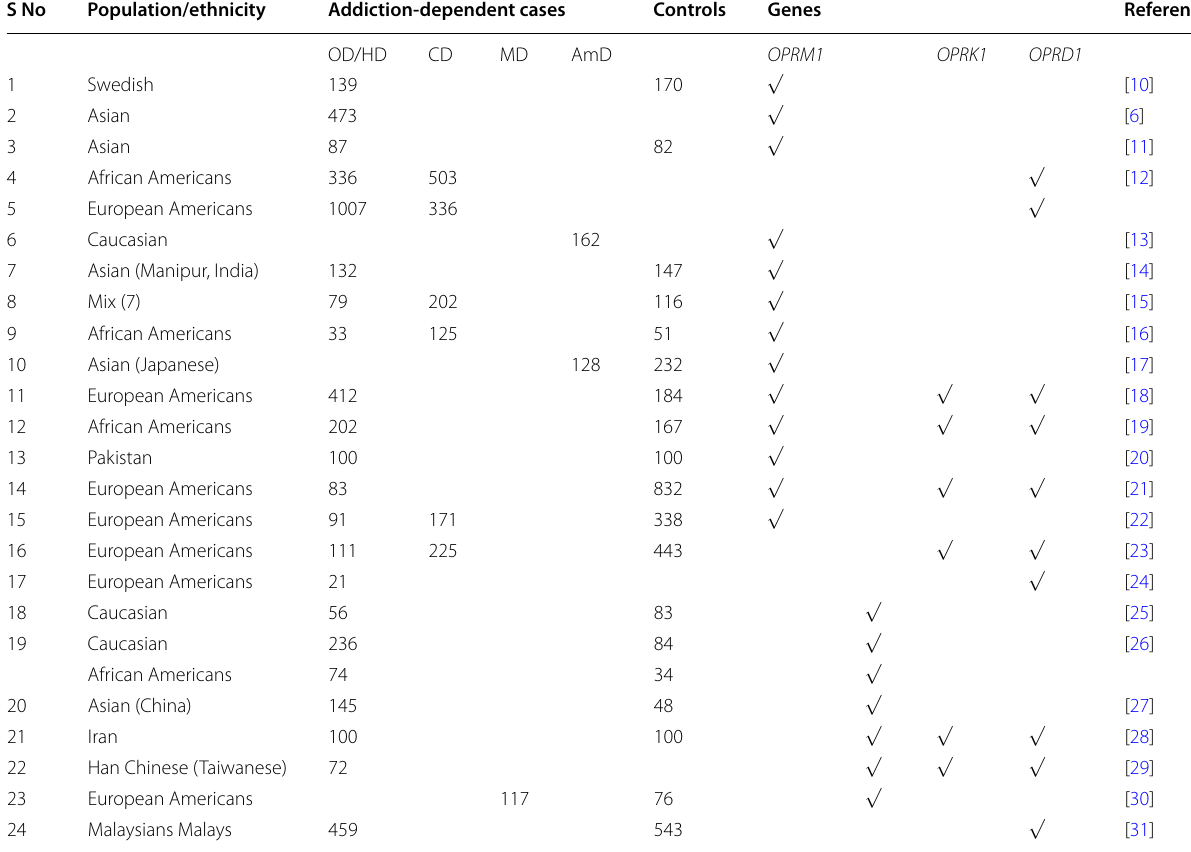
The table depicts the association and pathway studies of drug addiction cases and dependent cases which have been analysed for OPRM1, OPRK1 and OPRD1 genes studies from different